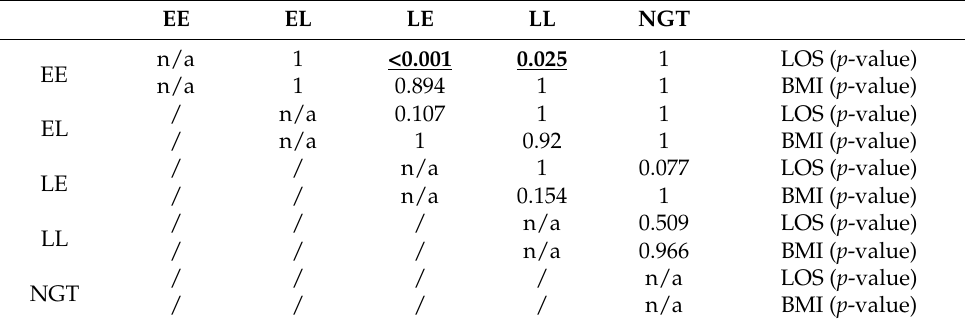
Table 4. Comparisons of treatment outcomes among treatment